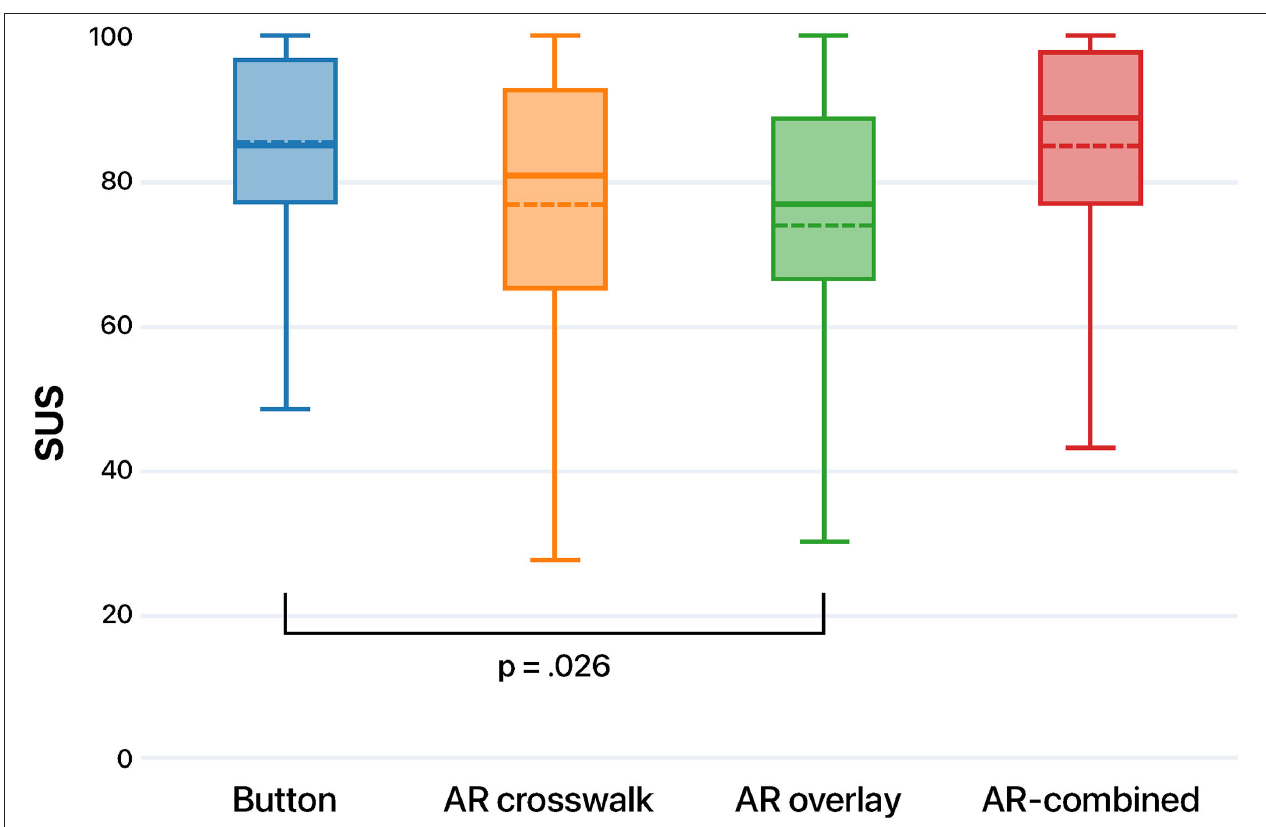
FIGURE 5 | Results of the SUS questionnaire. Median = solid line; mean = dotted line, p-values reported for significant pairwise